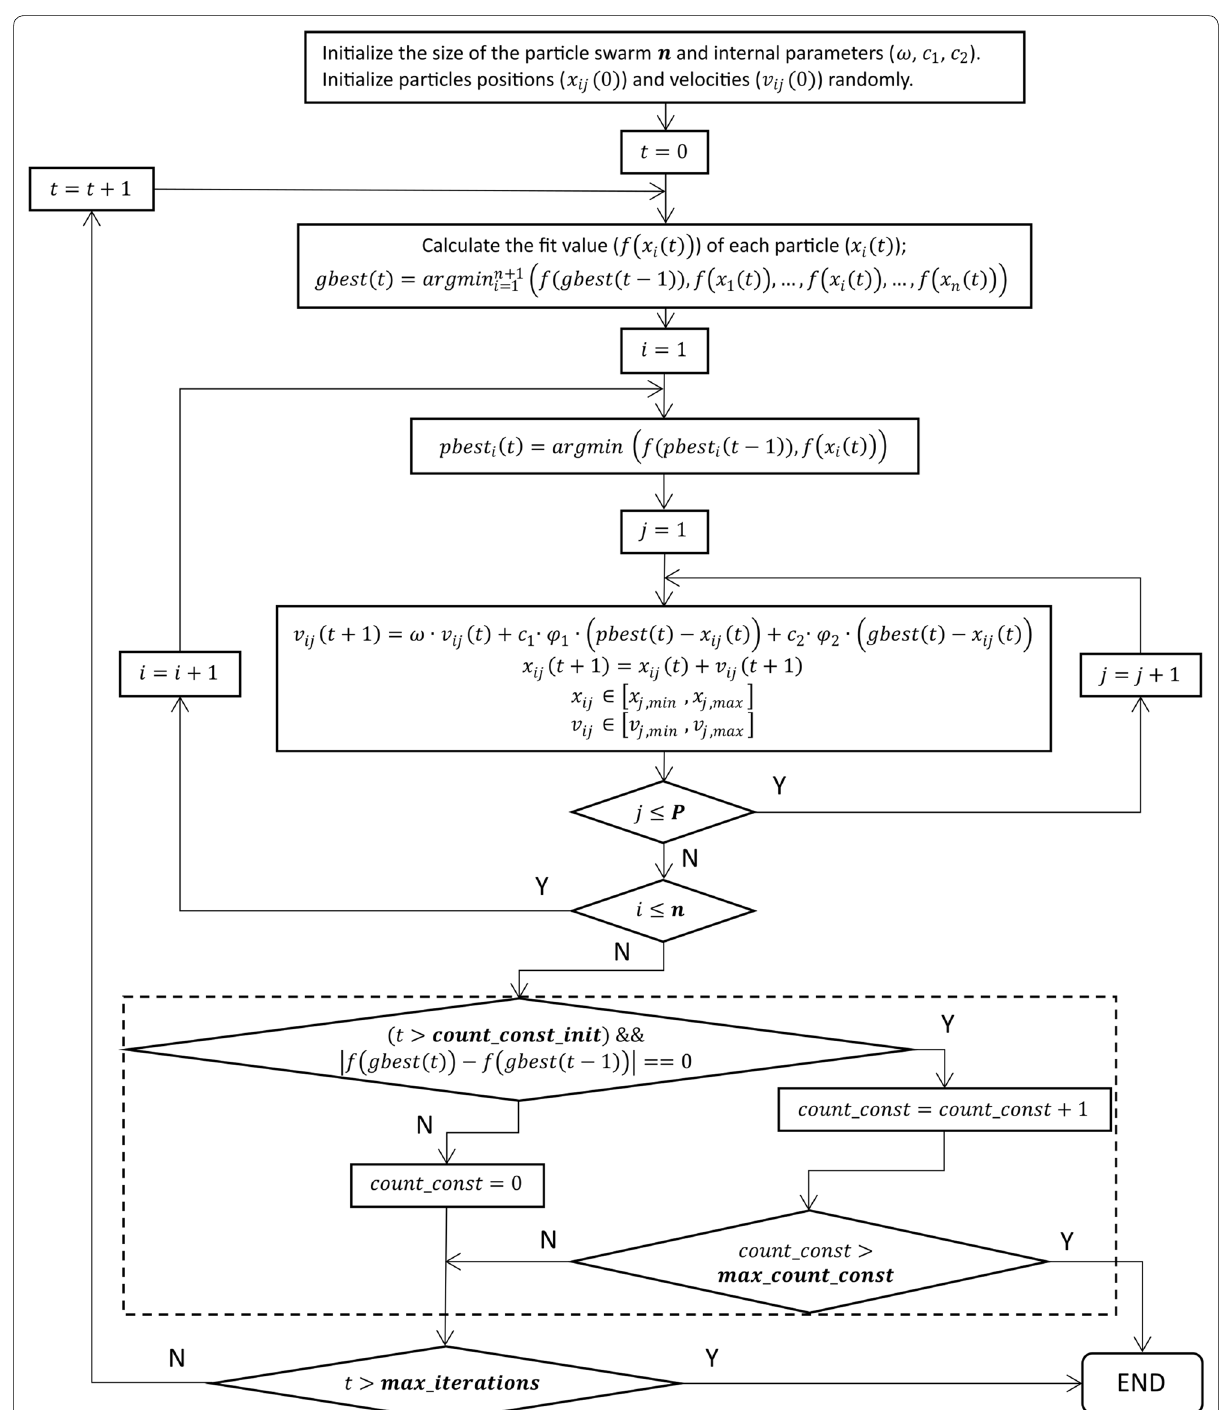
Fig. 1 Flowchart of the standard PSO algorithm implemented. n : swarm population size; P : number of plasma parameters; max_iterations : maximum number of generations; t : generations counter (from 1 to max_iterations ); i : particle’s id counter (from 1 to n ); j : parameter’s dimension from 1 to P ; v ij ( t ) and x ij ( t ) : i th particle’s j th dimension’s t th generation’s velocity and position value, respectively; count_const: counter of stagnation cases (i.e., identical fit values of g best ; from 1 to max_count_const ); count_const_init : minimum generation to start counting for stagnation